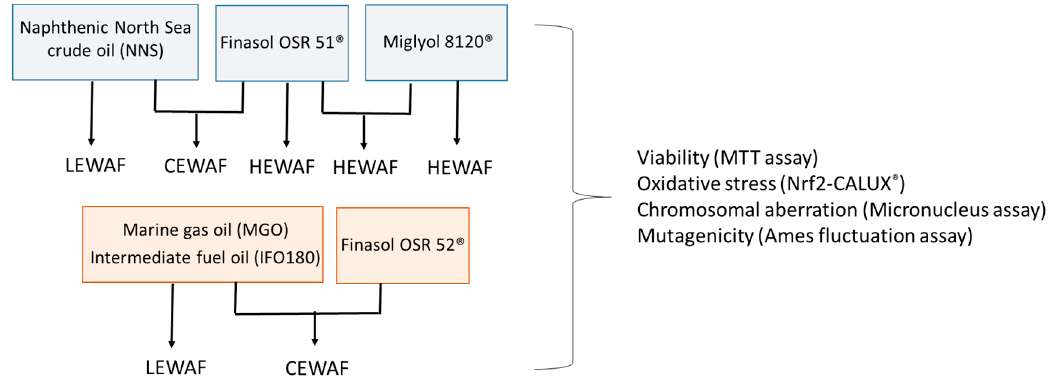
Figure 1. Overview of different WAF approaches and investigated endpoints. Low energy (LE-), chemically enhanced (CE-), and high-energy (HE-) WAFs of individual combinations were prepared according to Singer et al. [36]. The petroleum product types were combined with different dispersants due to oil-specific characteristics.